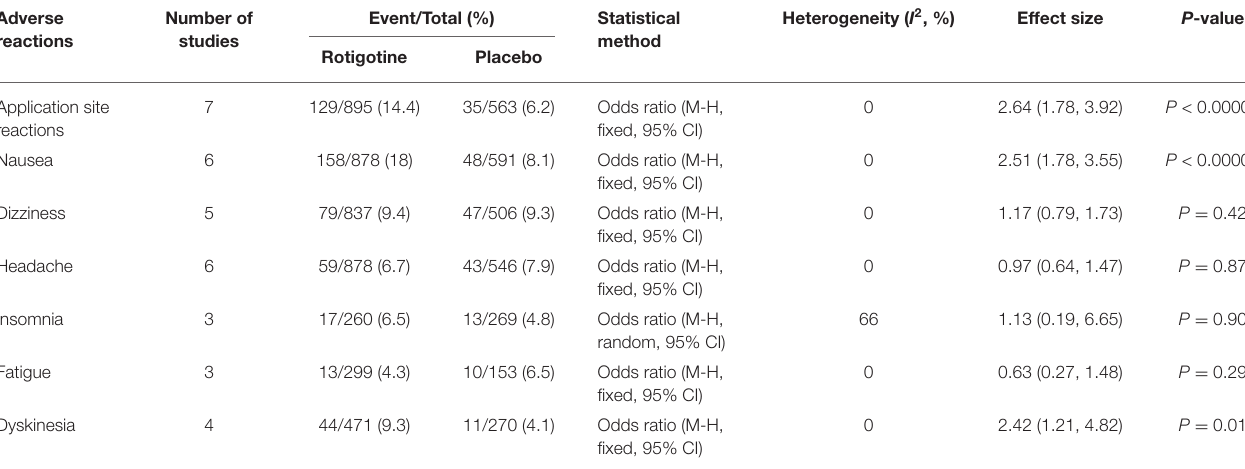
TABLE 4 | Characteristic of adverse